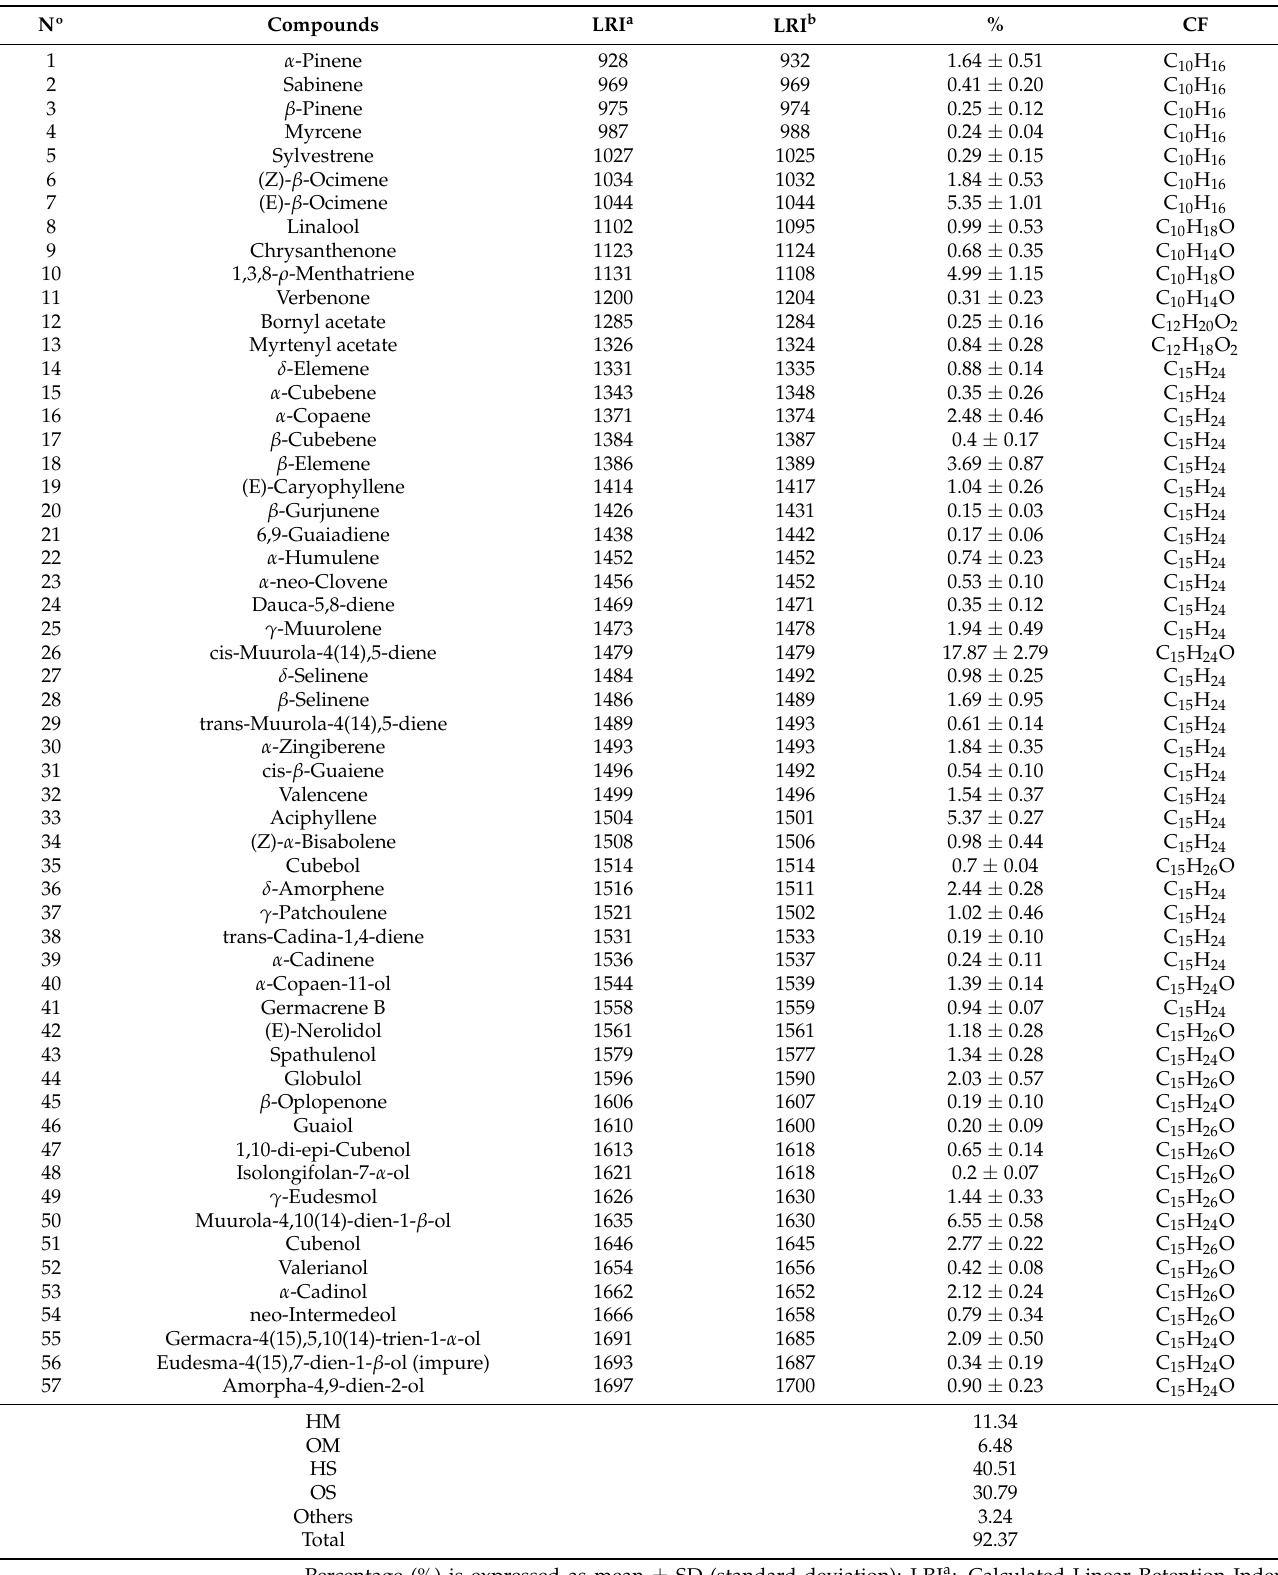
Table 2. Chemical compounds present in the essential oil of the leaves of H . spectabile